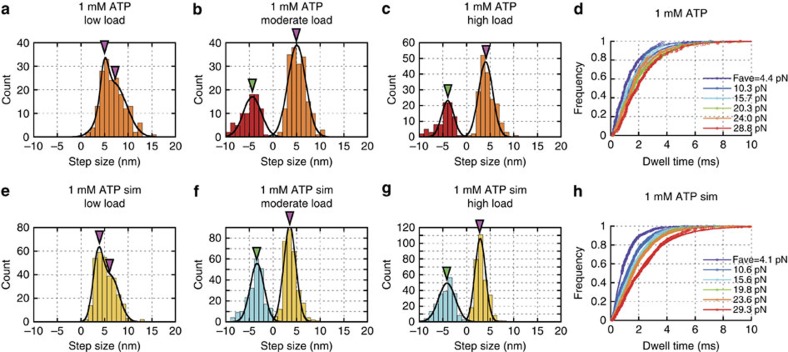
Step size and dwell time of myosin-rod cofilaments.(a–c) Histograms of step sizes experimentally observed at 1 mM ATP for low loads (mean of 4.4 pN) in a, moderate loads (mean of 15.4 pN) in b and high loads (mean of 29.3 pN) in c. Also see Supplementary Fig. 2 for other ATP concentrations. (e–g) Histograms of step sizes obtained from the simulation model at 1 mM ATP for low loads (mean of 4.1 pN) in e, moderate loads (mean of 15.3 pN) in f and high loads (mean of 30.1 pN) in g. Also see Supplementary Fig. 2 for other ATP concentrations. (d,h) Cumulative probability distributions of the dwell time fitted to a double exponential function for experimental data in d and simulation data in h. The time constants calculated from double exponential fits were used to calculate mean dwell times as shown in Fig. 3g–i. Arrowheads indicate the peak points of single or double Gaussian functions. Step sizes at the peak were used as the mean step size in Fig. 3a–c.